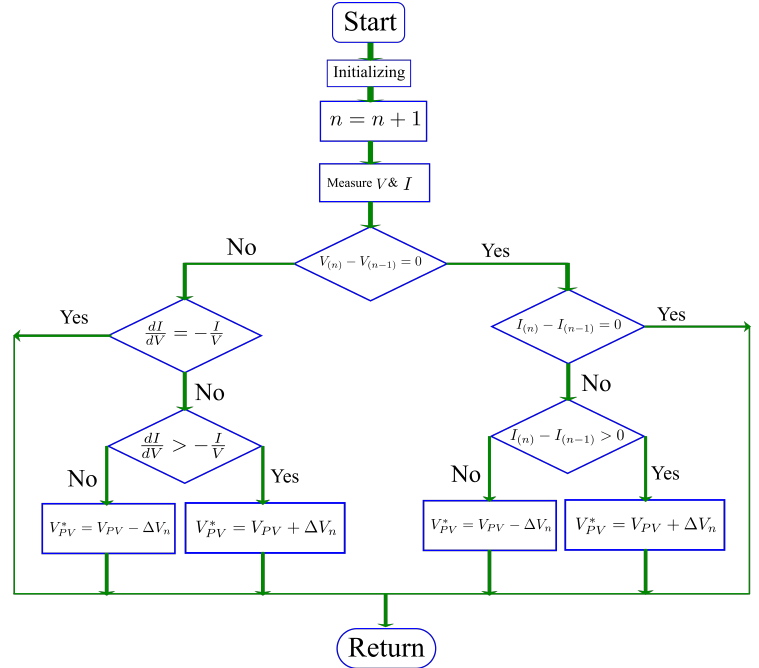
Figure 10. Illustration of the Incremental conductance